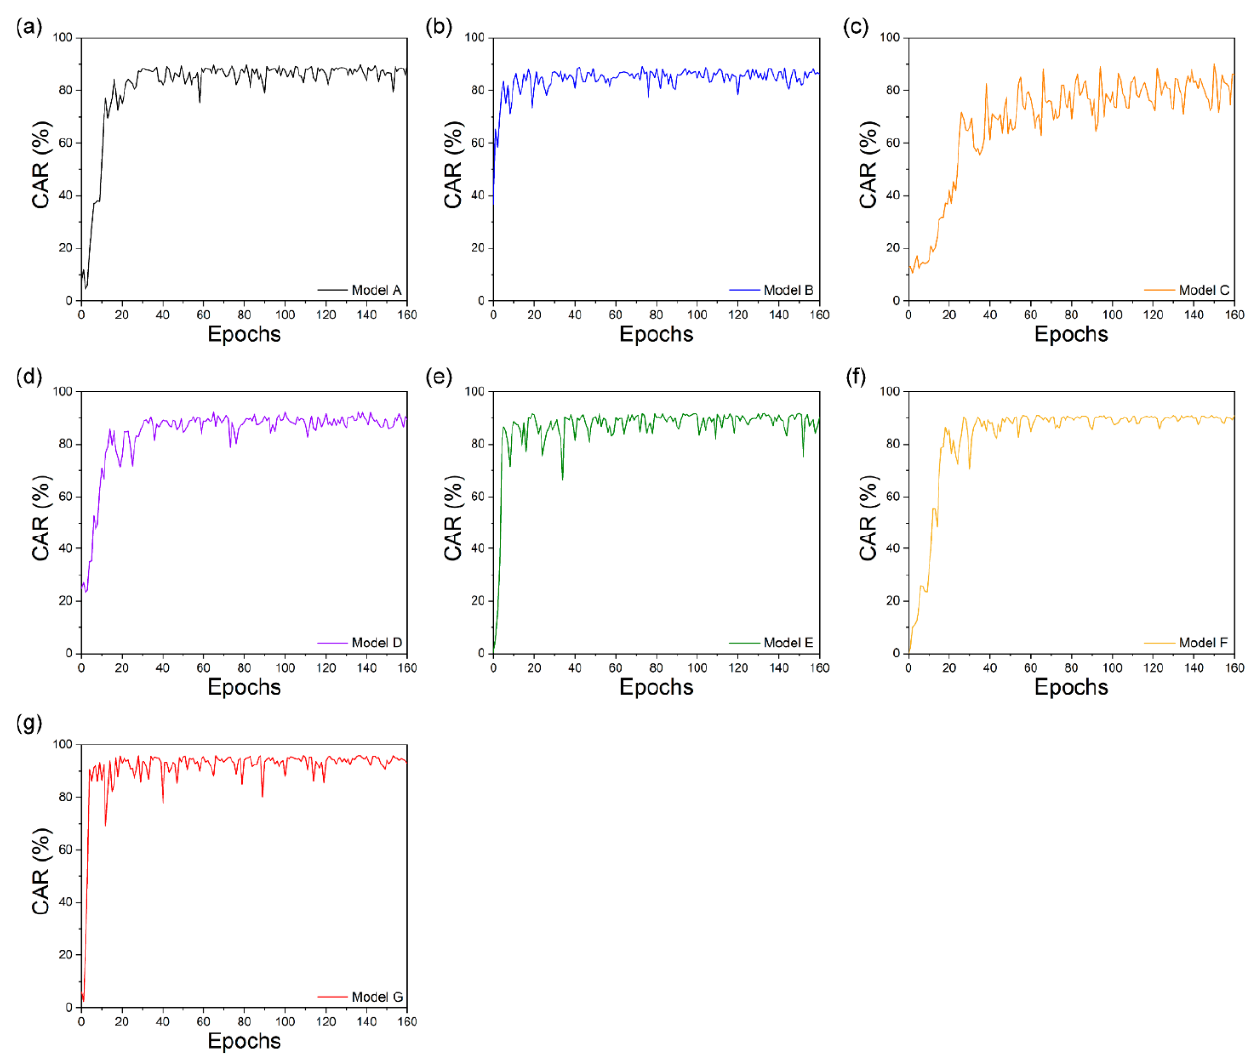
Figure 9. Training steps for CAR comparing the proposed model toother models: Models ( a ) A; ( b ) B; ( c ) C; ( d ) D; ( e ) E; ( f ) F; and ( g ) G.